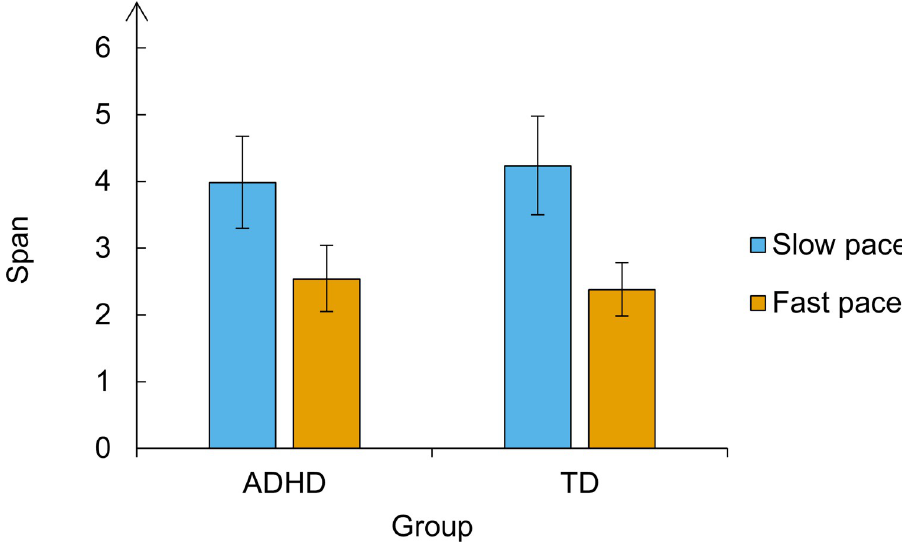
Fig 2. Mean spans per group and pace condition in Experiment 1. The vertical lines represent the confidence intervals.